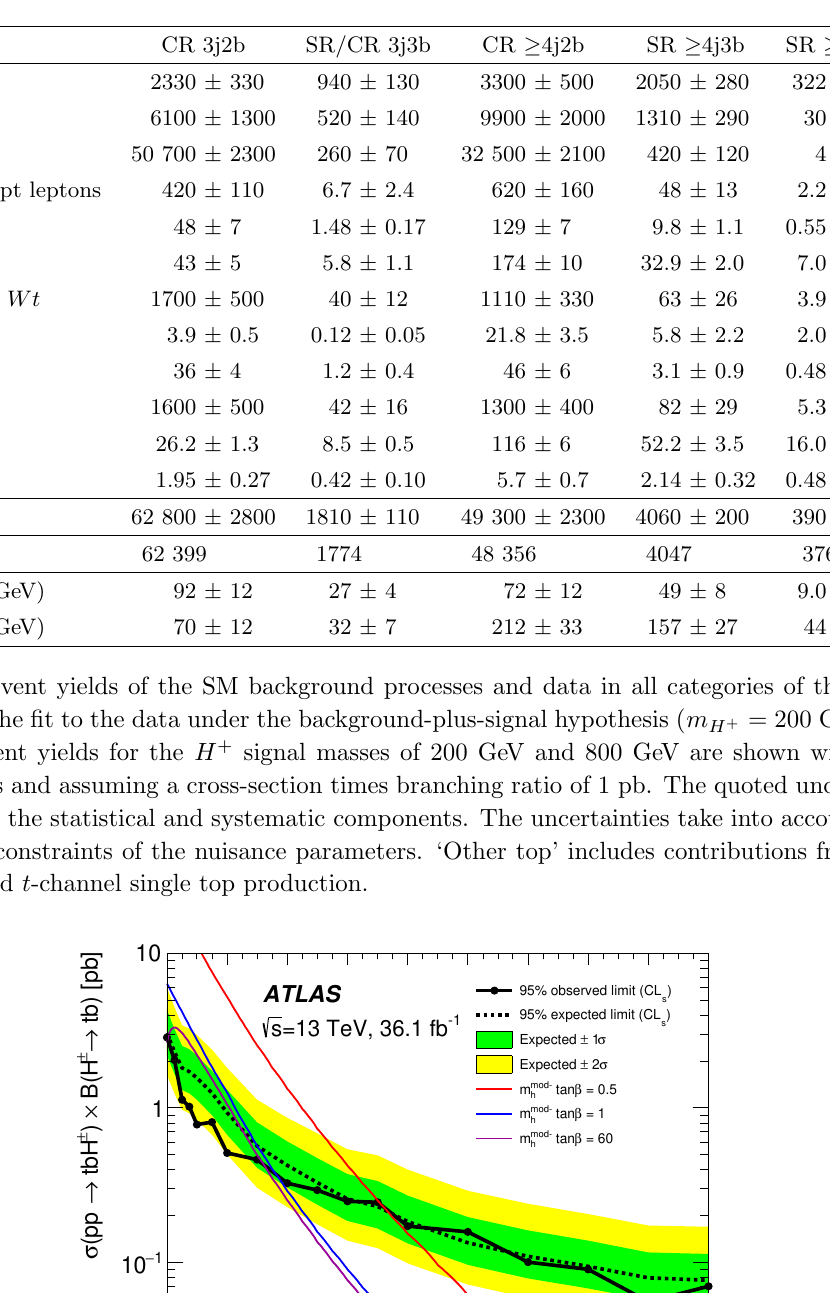
Figure 8. Expected and observed limits for the production of H + ! tb in association with a top quark and a bottom quark. The bands surrounding the expected limit show the 68% and 95% con- (cid:12)dence intervals. The limits are based on the combination of the ‘ +jets and ‘‘ (cid:12)nal states. Theory predictions are shown for three representative values of tan (cid:12) in the m mod (cid:0) benchmark scenario [28]. h Uncertainties in the predicted H + cross-sections or branching ratios are not considered.